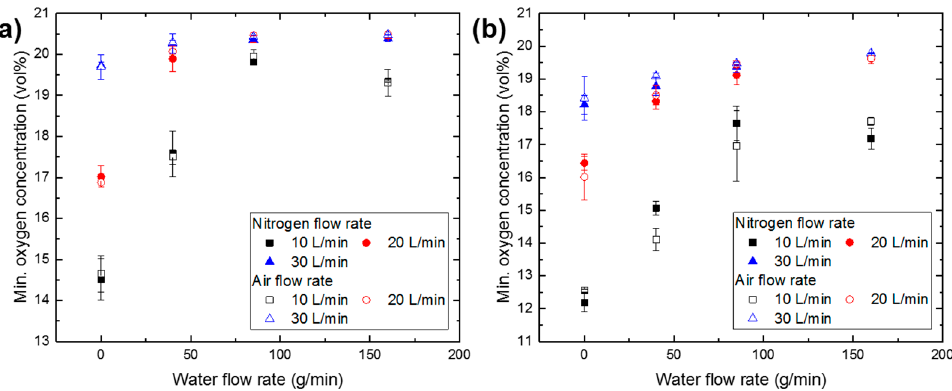
Figure 13. Minimum oxygen concentration for nitrogen and air (note that the scales of y -axis in both figures are different): ( a ) HRR = 1.17 kW and ( b ) HRR = 5.23 kW.